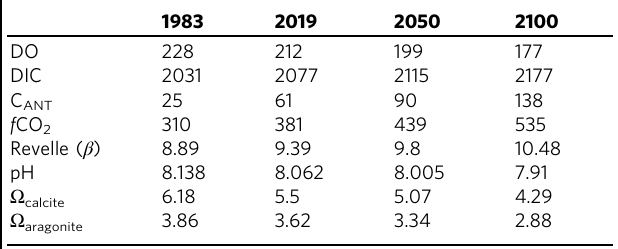
Table 2 Mean annual values for DO and ocean carbonate chemistry in 1983, 2019, and predictions for mid-century (2050) and end-of-century scenario (2100) with extrapolation of current trends to 2050 and